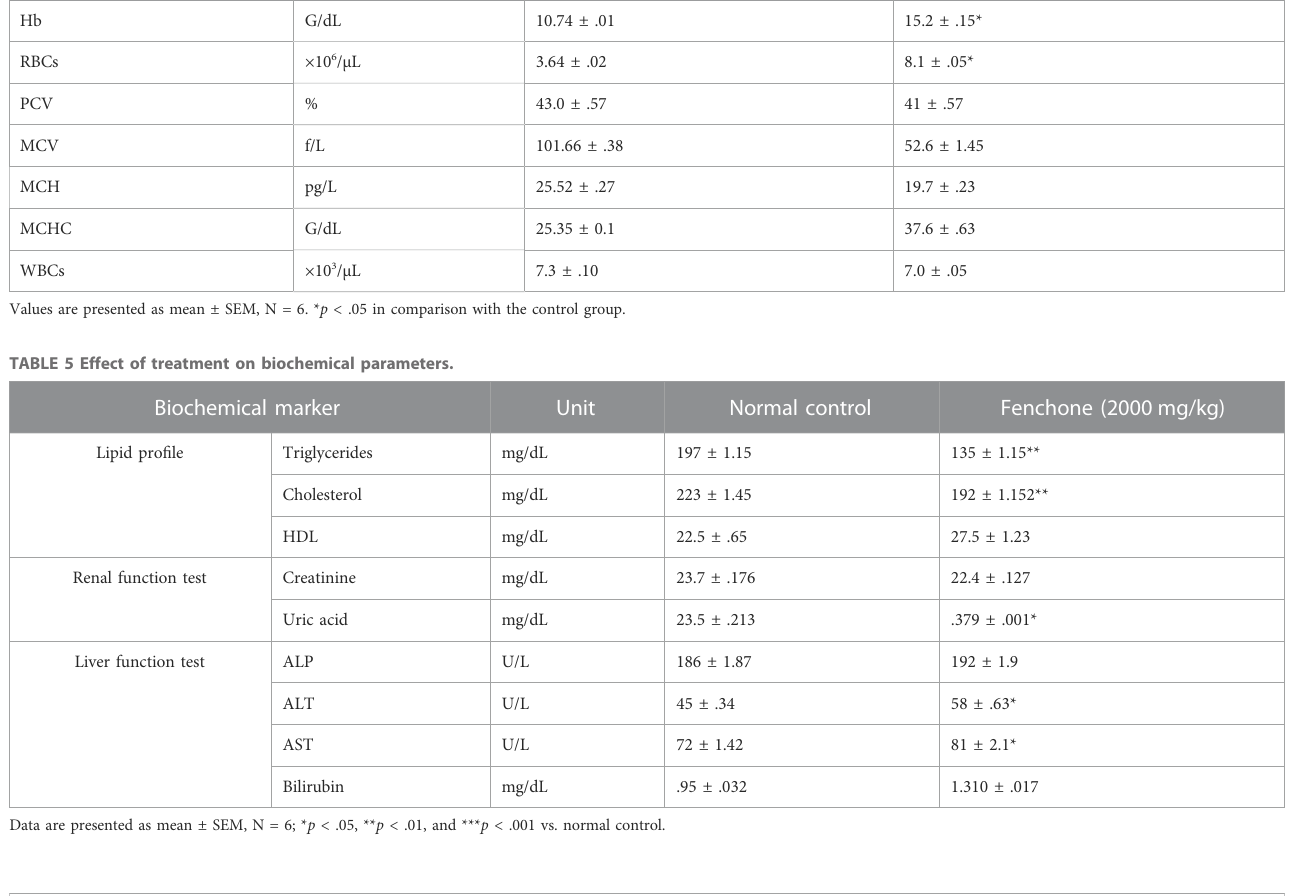
TABLE 4 Analysis of complete blood count in animals treated with fenchone (2000 mg/kg) in the acute toxicity study. Parameter